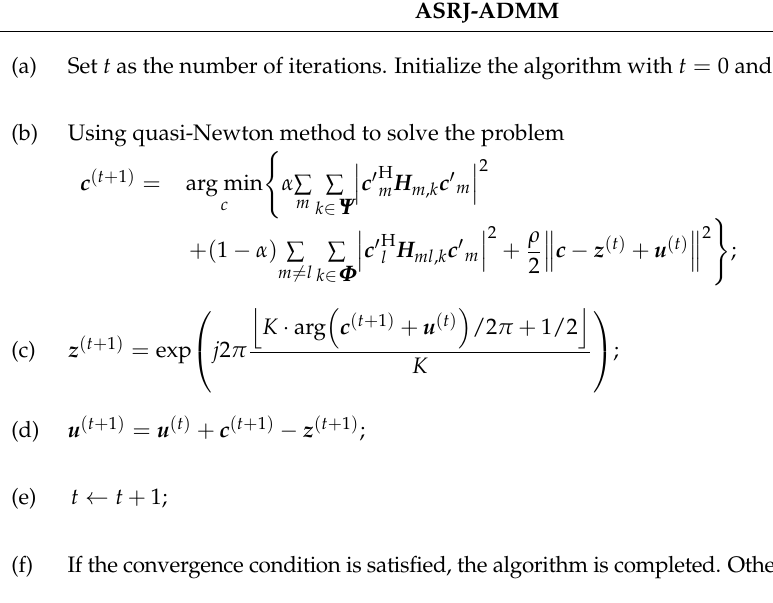
Table 2. ASRJ-ADMM